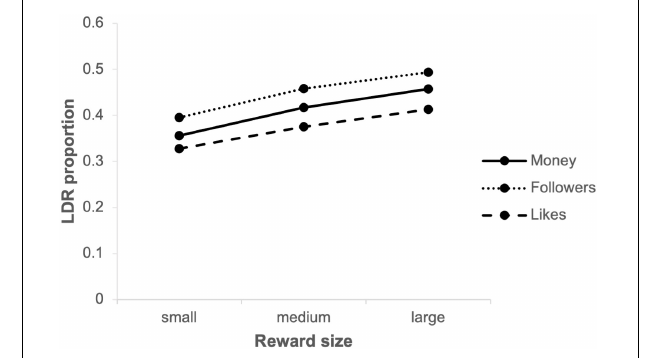
FIGURE 2 | Mean LDR proportions by reward